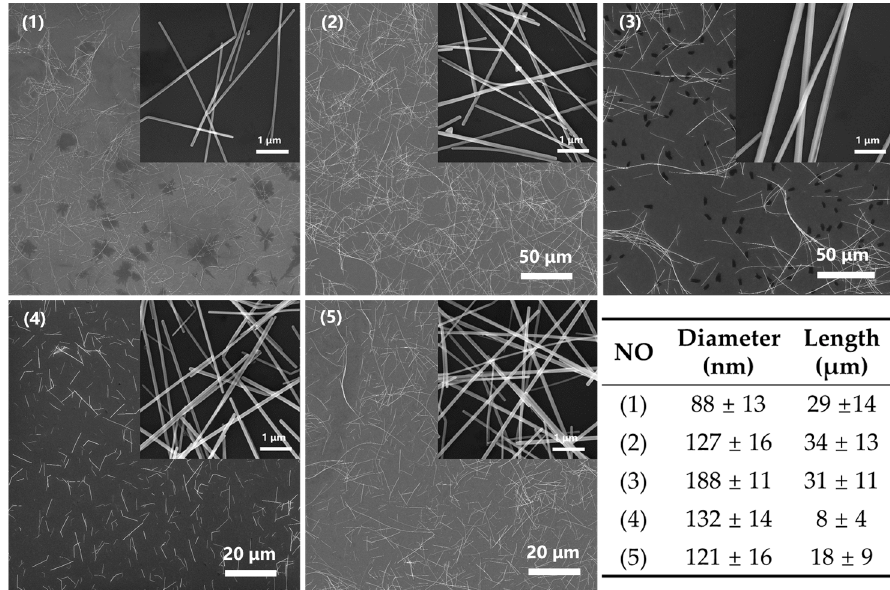
Figure 1. SEM images of five kinds of silver nanowires and their sizes. The scale of each figure in the up-right corner is 1 μ m.